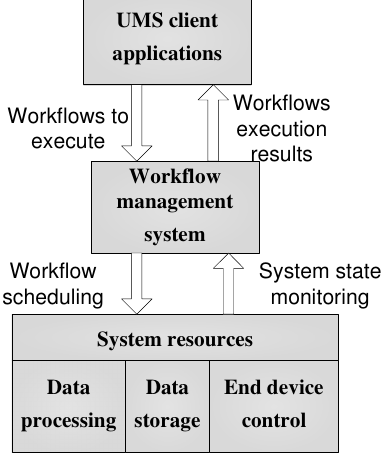
Fig. 1. Overall system